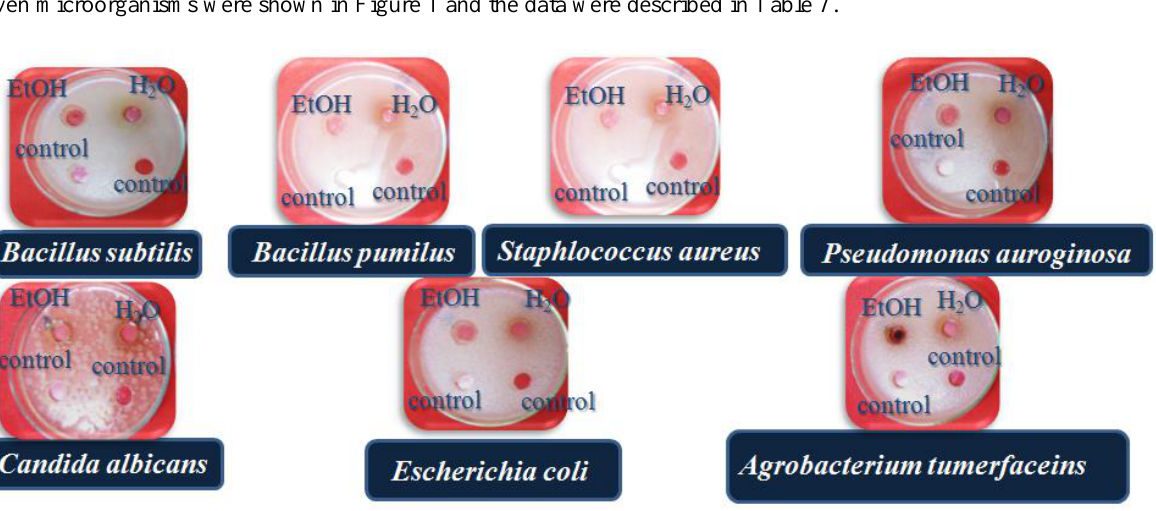
Figure 1. Inhibition of ethanol and watery extracts of the stem barks of Phyllanthus albizzioides on seven microorganisms Table 7. Antimicrobial activities of ethanol and watery extracts of the stem barks of Phyllanthus